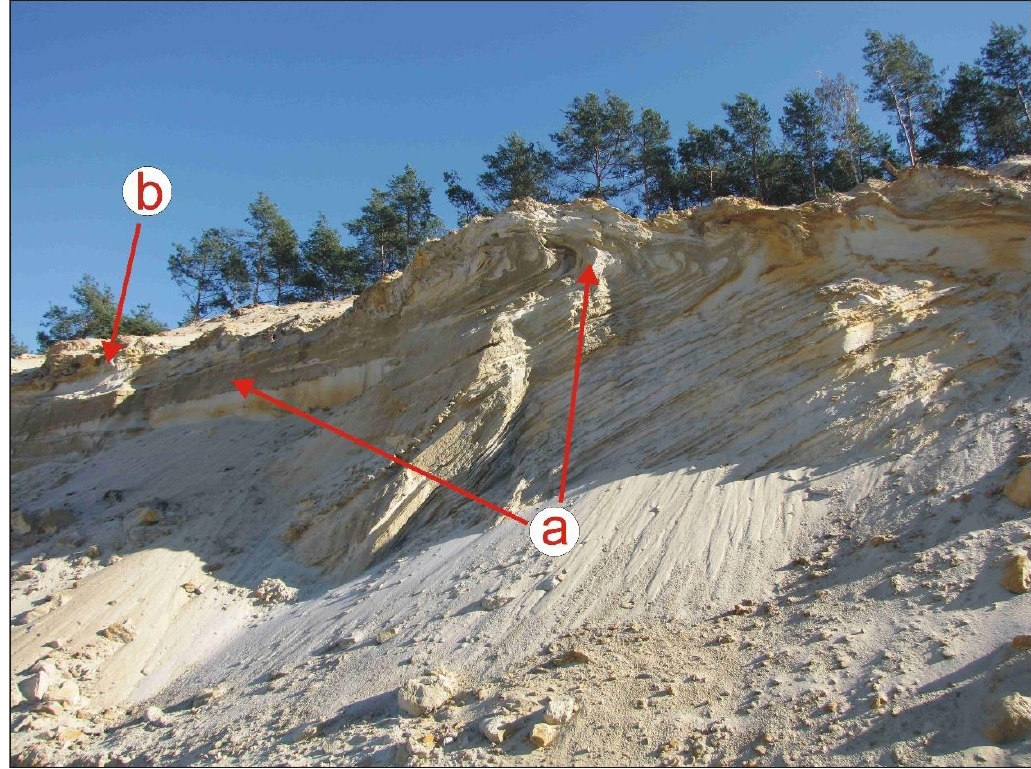
Figure 5. Layers of marginal sandy silts disturbed by the ice sheet: (a) in the open cast pit wall of the sand mine in the southern part of the study area; (b) a zone of former hanging groundwater level I (photo: J.M. Waga).